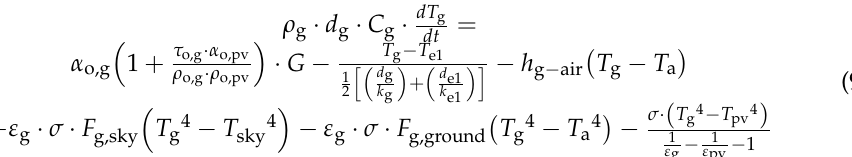
Figure 4. Cross-section of the PV/T collector and description of each layer. The glass layer covers both the input and output heat flow. The input heat flow includes absorbed solar radiation and reflection between the glass and the PV cell layer, while the output heat flow includes conductive heat transfer with the first layer of EVA foil, convective heat transfer with air, and radiation heat transfer with the sky and ground. The temperature distribution of the glass layer is described by (9):